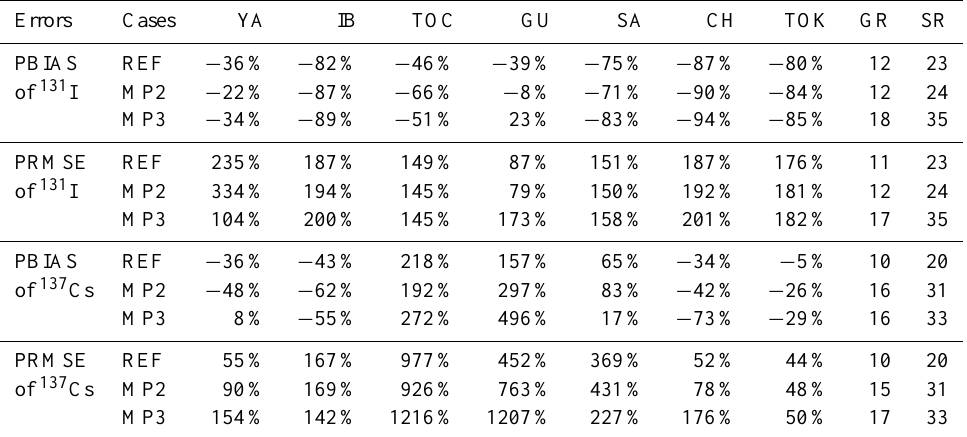
Table 5. The PBIAS and PRMSE of total daily depositions of 131 I and 137 Cs with different microphysics schemes. GR represents the global ranks for PBIAS or PRMSE, and SR represents for the sum of the global ranks. The definition of GR and SR is shown in Sect. 3.1.2. “YA”, “IB”, “TOC”, “GU”, “SA”, “CH” and “TOK” represent the stations “YAMAGATA”, “IBARAKI”, “TOCHIGI”, “GUNMA”, “SAITAMA”, “CHIBA” and “TOKYO”,